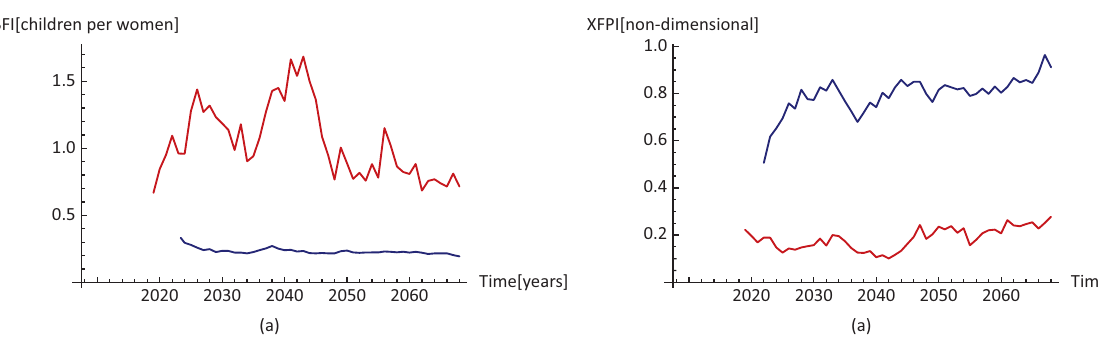
Figure 4. Future simulation (genetic algorithm) of fertility and the Family Policies Index: Spain, 2020–2060. Notes: The GA1 (free) is presented in red and the GA2 (conditional on goals consistency) is presented in